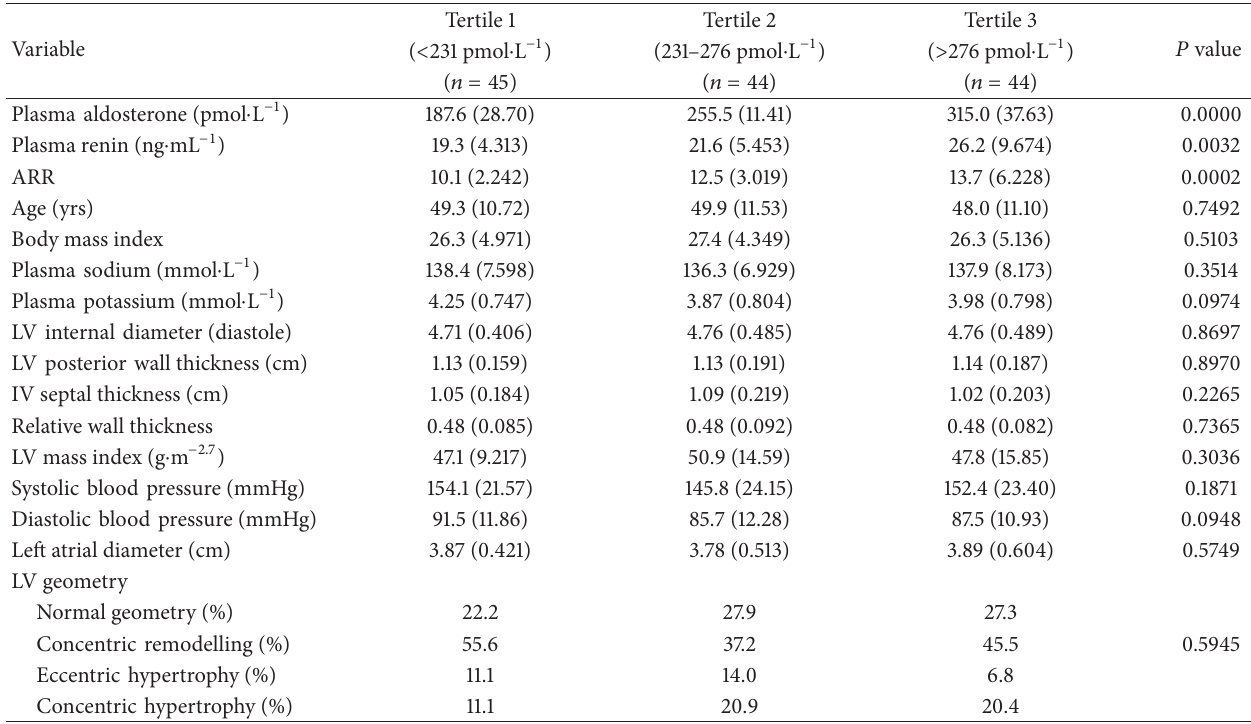
Table 3: Biochemical, hormonal, and echocardiographic characteristics of the subjects according to aldosterone concentration tertiles. Variable